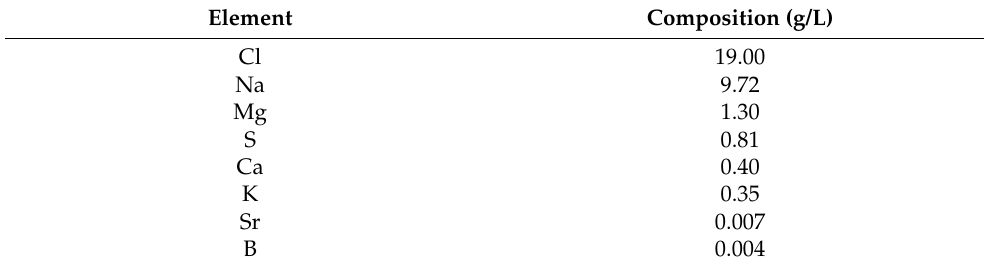
Table 1. Chemical composition of artificial seawater used for corrosion